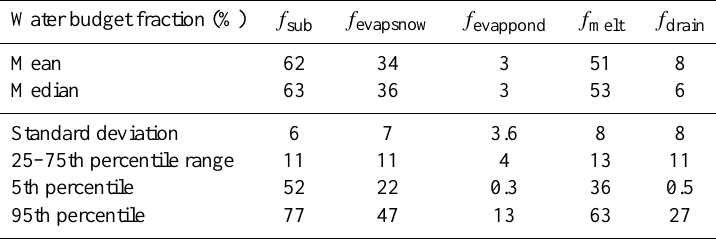
Table 1. Optimal parameter estimates for partitioning in the surface water budget given in units of %. All fluxes are normalized by the total loss of snow mass. The sum f sub + f evapsnow + f evappond equals 100% of the surface flux in each simulation in the Monte Carlo ensemble.